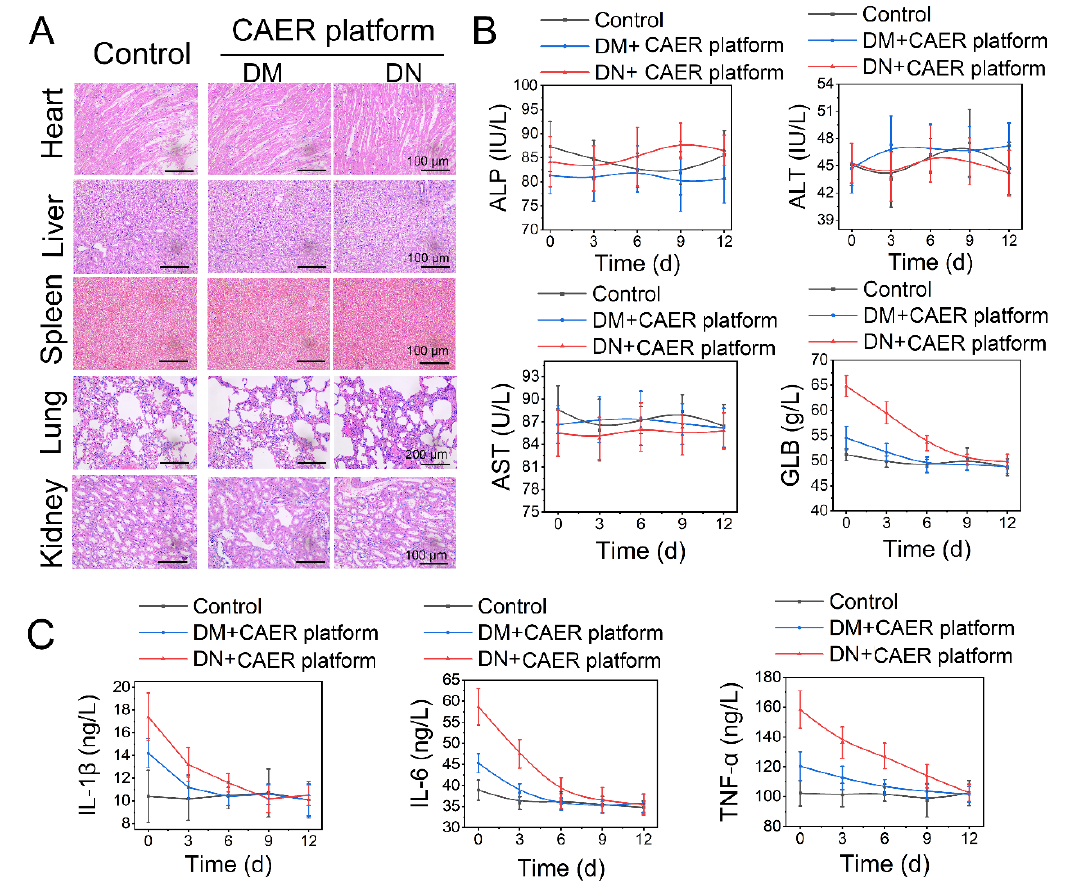
Figure 6. Biosafety of the CAER platform. ( A ) H&E staining of sections of the main organs, including heart, liver, kidney, lung, and spleen, after the CAER platform treatment. ( B ) Parameters of serum biochemistry profiles. ( C ) The degree of inflammation factors, including IL- 1β, IL -6, and TNF- α.